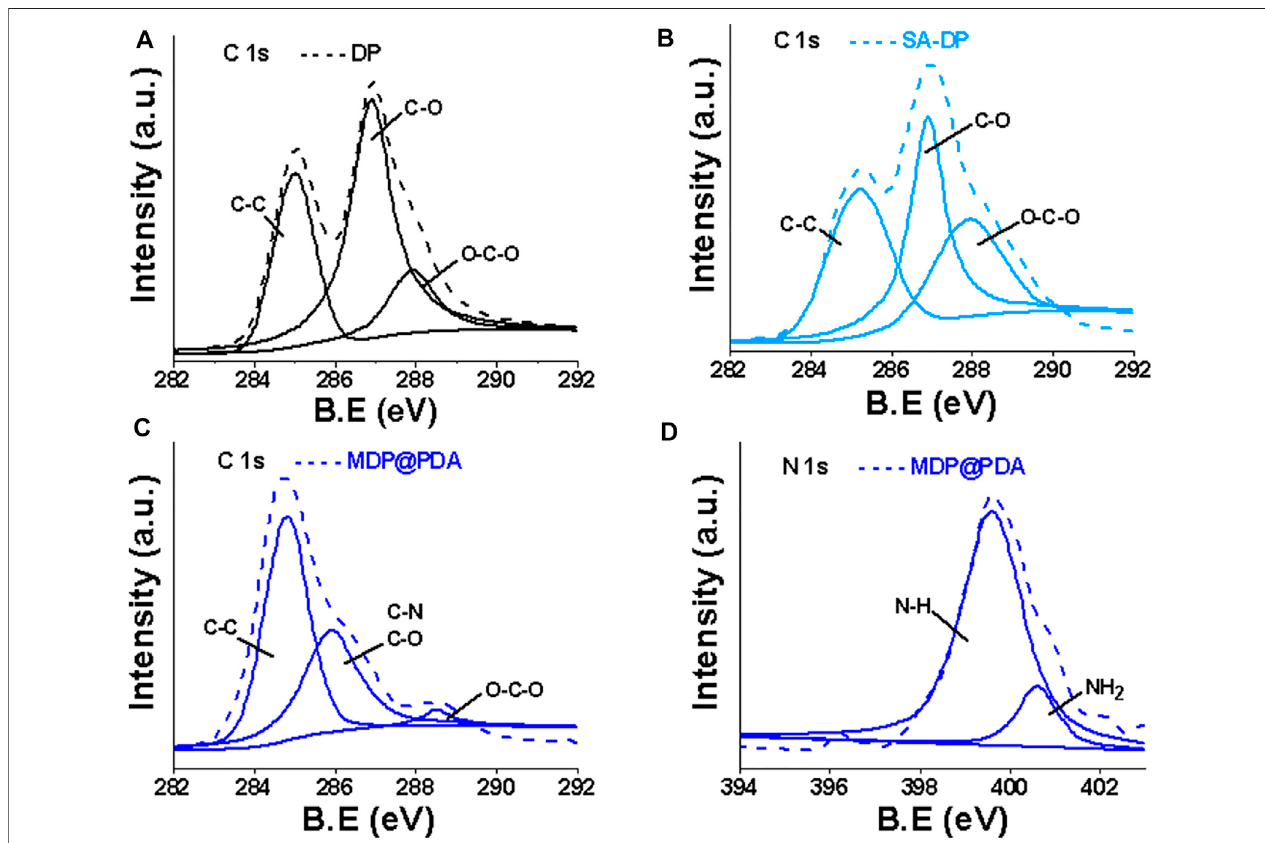
FIGURE 5 | The C 1s XPS spectra of (A , B) DP and SA-DP, the C 1 s, and N 1s XPS spectra of (C , D) MDP@PDA.